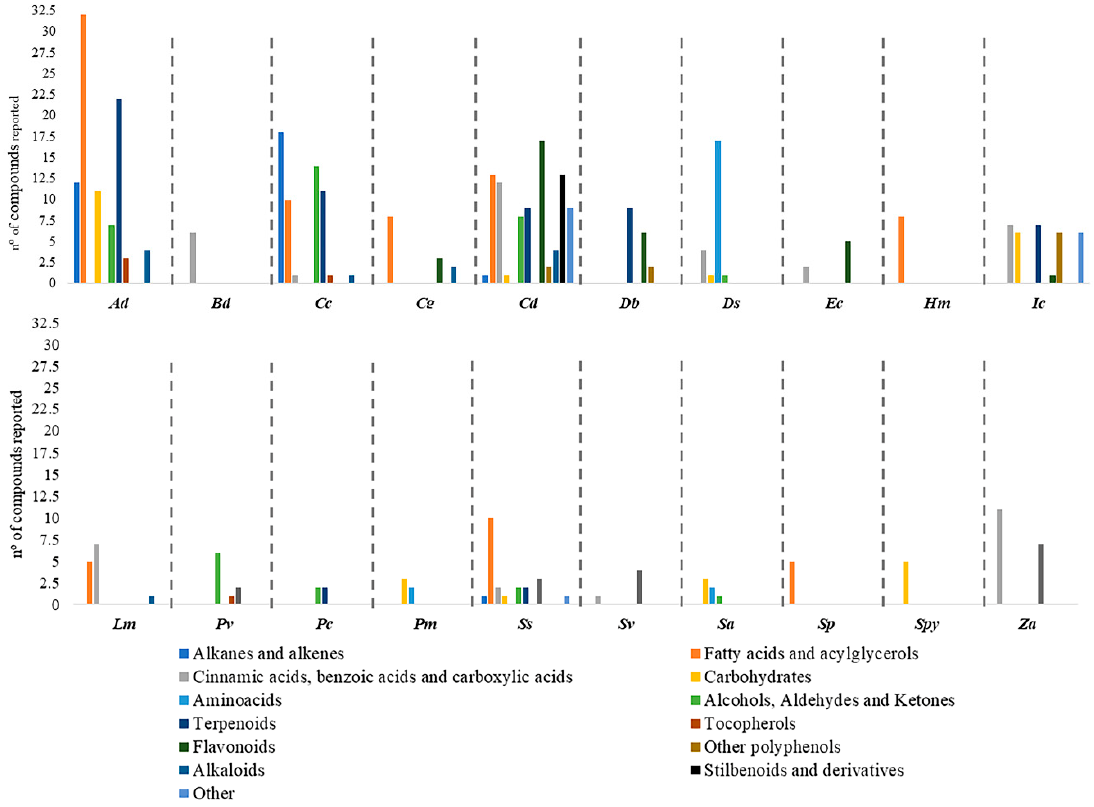
Figure 2. Graphical presentation of the total number of compounds reported in each class of compounds for the halophytic grasses studied. Being, Ad : Arundo donax; Bd : Buchloe dactyloides ; Cc : Cenchrus ciliaris ; Cg: Chloris gayana ; Cd : Cynodon dactylon ; Db : Desmostachya bipinnata; Ds : Distichlis spicata ; Ec : Echinochloa crus-galli; Hm : Halopyrum mucronatum ; Im : Imperata cylindrica ; Lm : Lolium multiflorum ; Pv : Panicum virgatum ; Pc : Pennisetum clandestinum ; Pm : Puccinellia maritima ; Ss : Saccharum spontaneum ; Sv : Setaria viridis ; Sa : Spartina anglica ; Sp : Spartina patens ; Spy : Sporobolus pyramidalis and Za : Zizania aquatica .